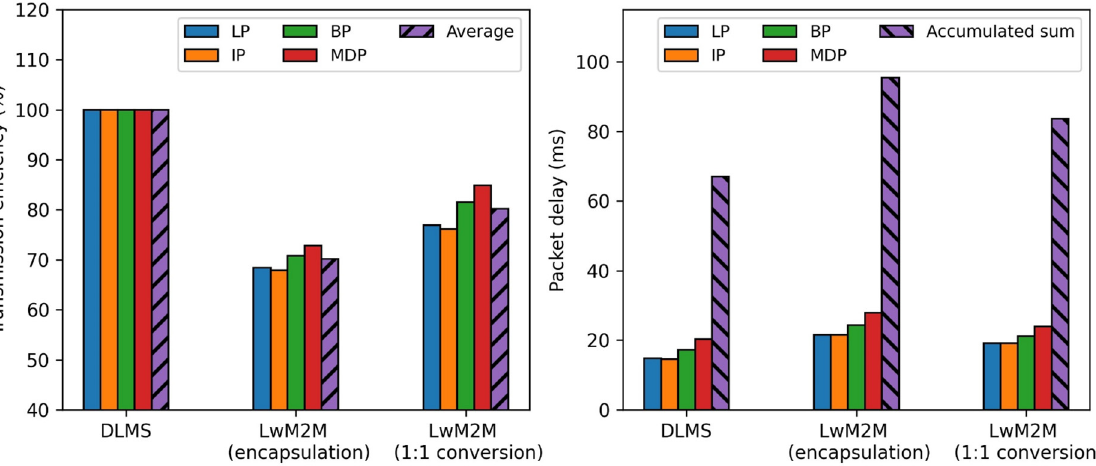
Figure 11. Comparison of the performance metrics (auth. encryption after session establishment).